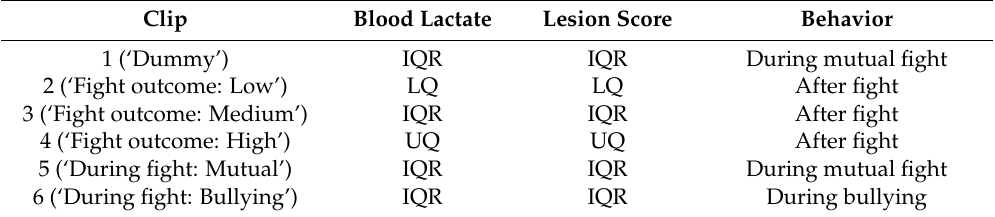
Table 2. Severity and content of each 20 s video clip displaying an aggressive encounter between two pigs. (LQ = lower quartile; IQR = interquartile range; UQ = upper quartile).